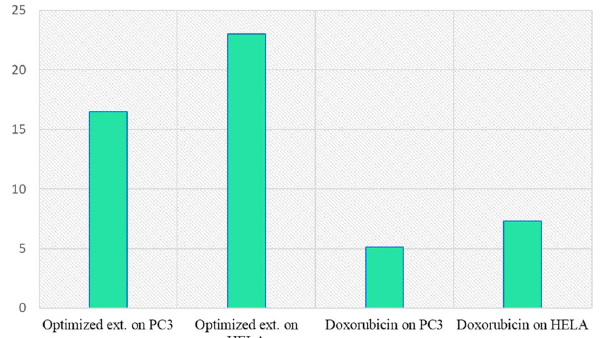
Figure 8. IC 50 of L. hispidulus optimized extract versus